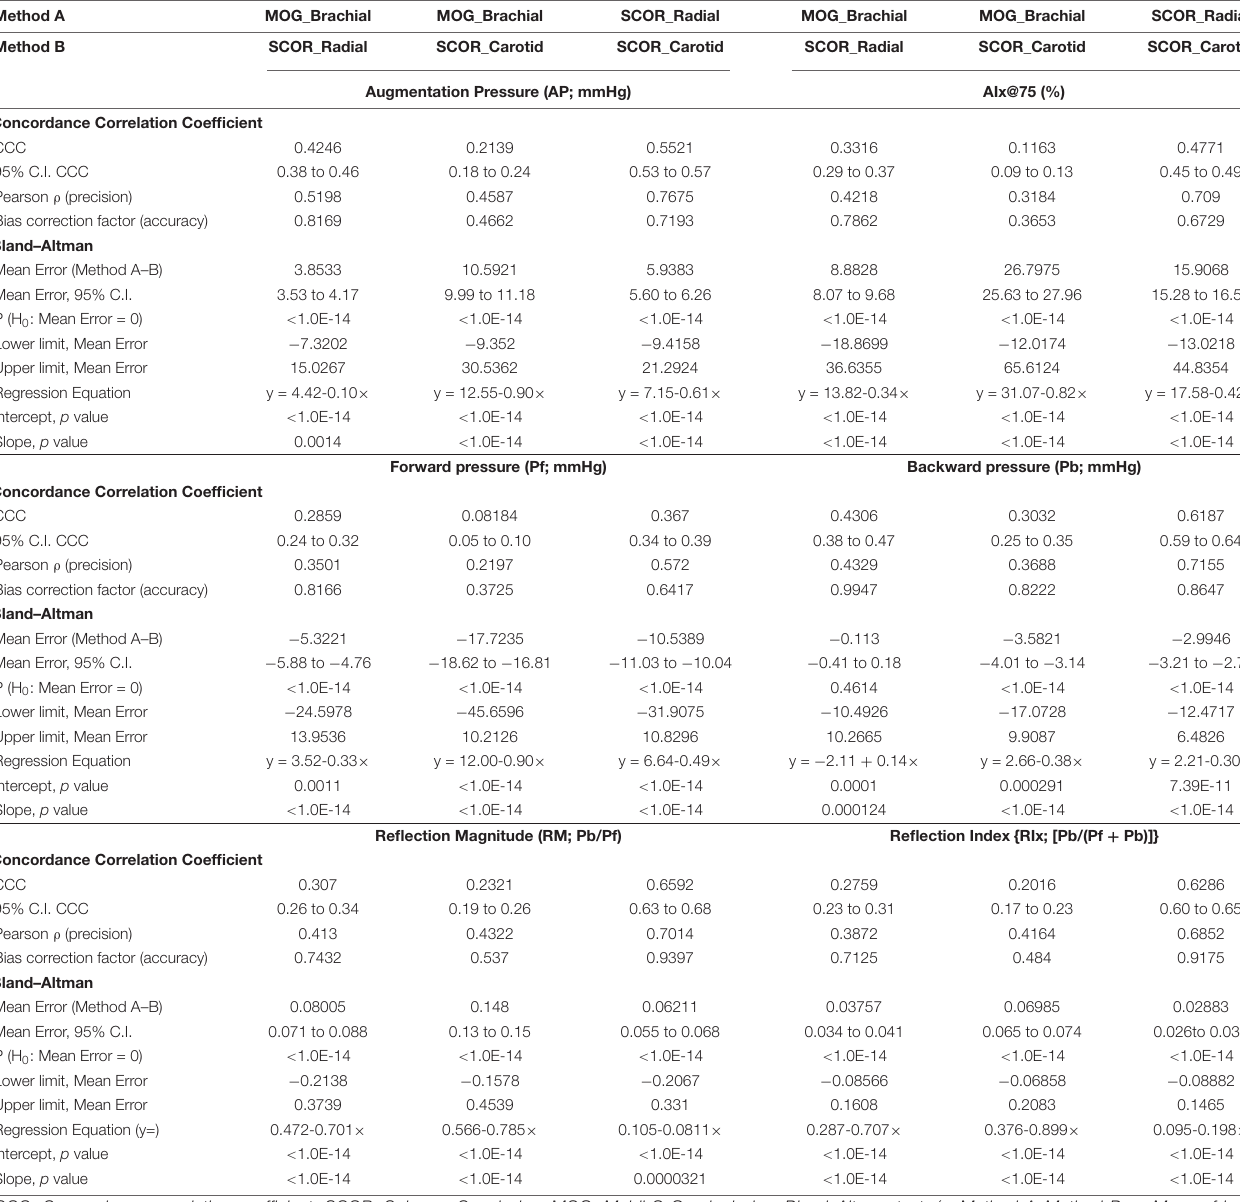
TABLE 3 | Agreement between central waveform-derived indexes obtained with carotid and radial applanation tonometry and brachial oscillometry: Concordance Correlation and Bland–Altman